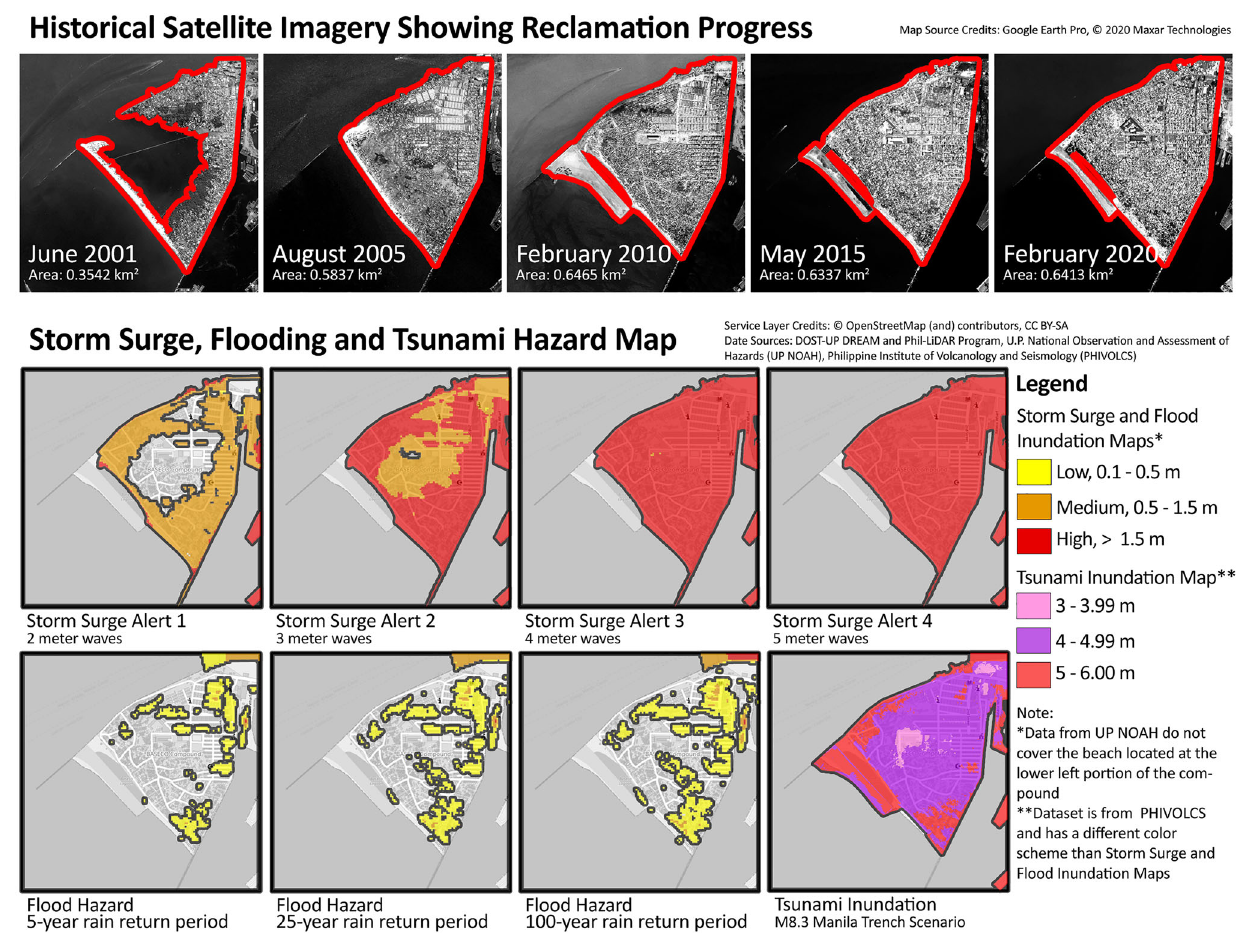
Fig. 2 Historical satellite imagery and coastal hazard risk of BASECO Compound in